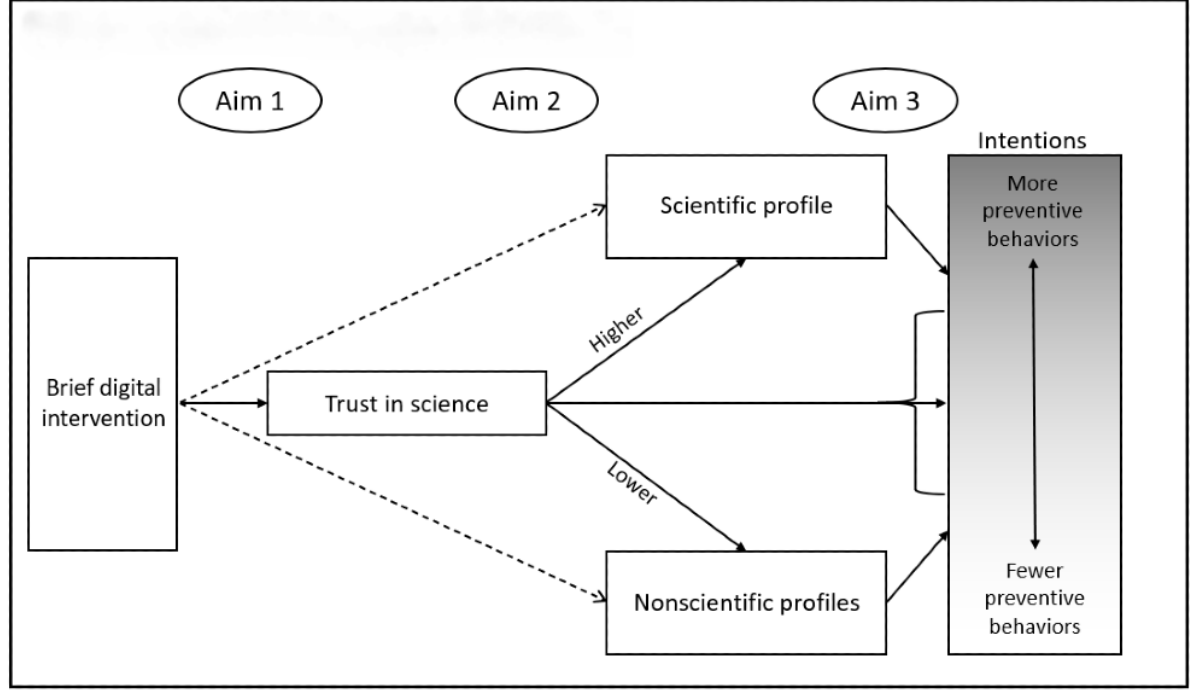
Figure 1. Conceptual framework of study